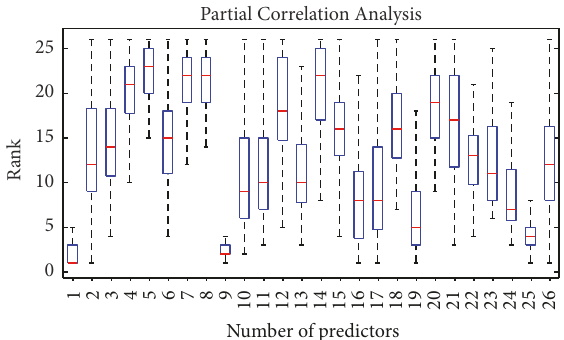
Figure 7: Rank of partial correlation of predictors in the 61